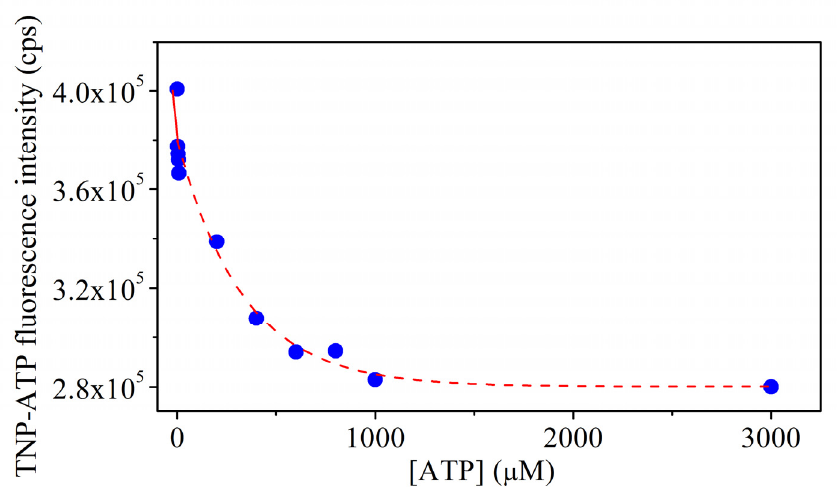
Figure 7. ATP is competitor of TNP ‐ ATP. The fluorescence emission of TNP ‐ ATP was measured in the presence of an increasing concentration of ATP. Based on the curve, the dissociation constant of ATP to Tm ‐ MreB is about 3.7 μ